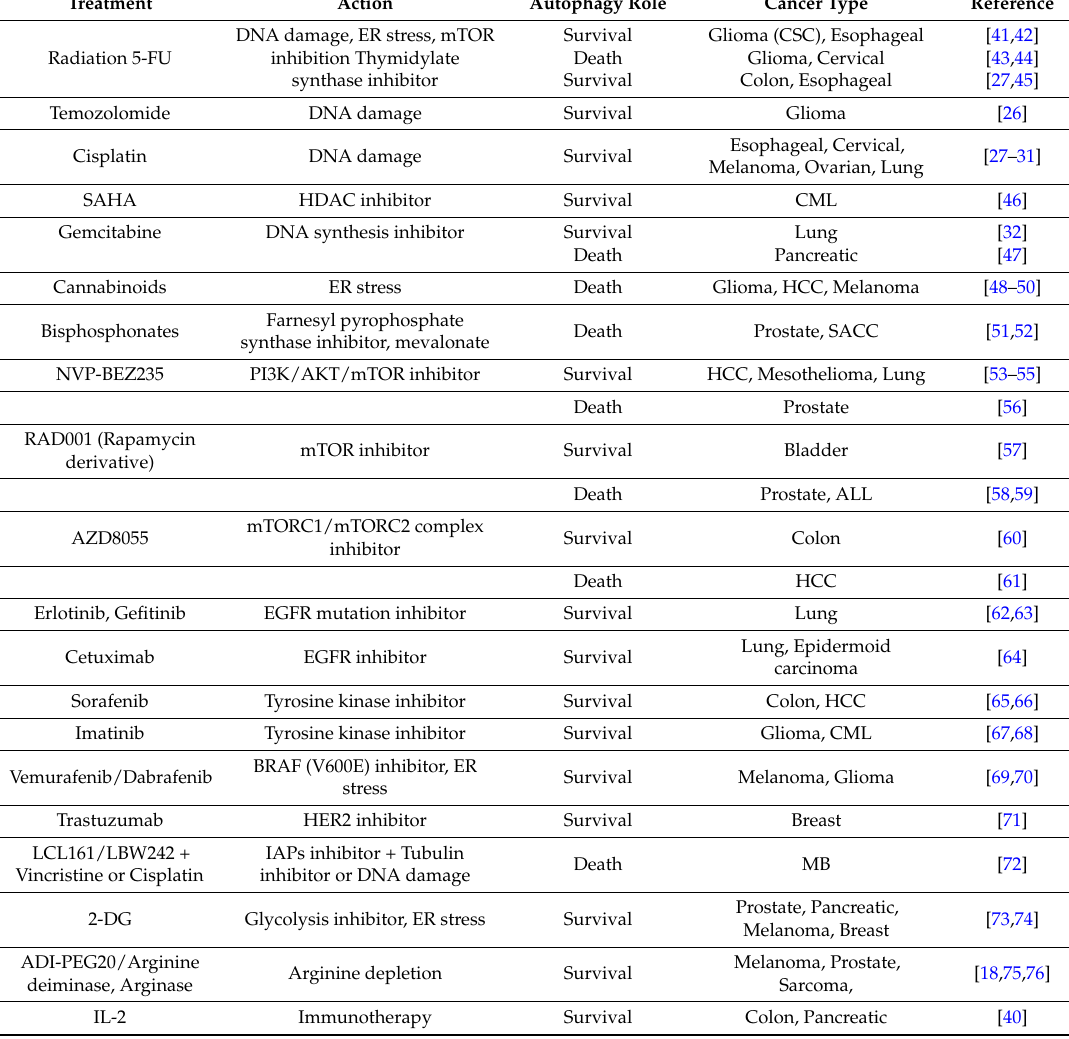
Table 1. Current and prospective treatments result in autophagy-mediated cancer cell death or